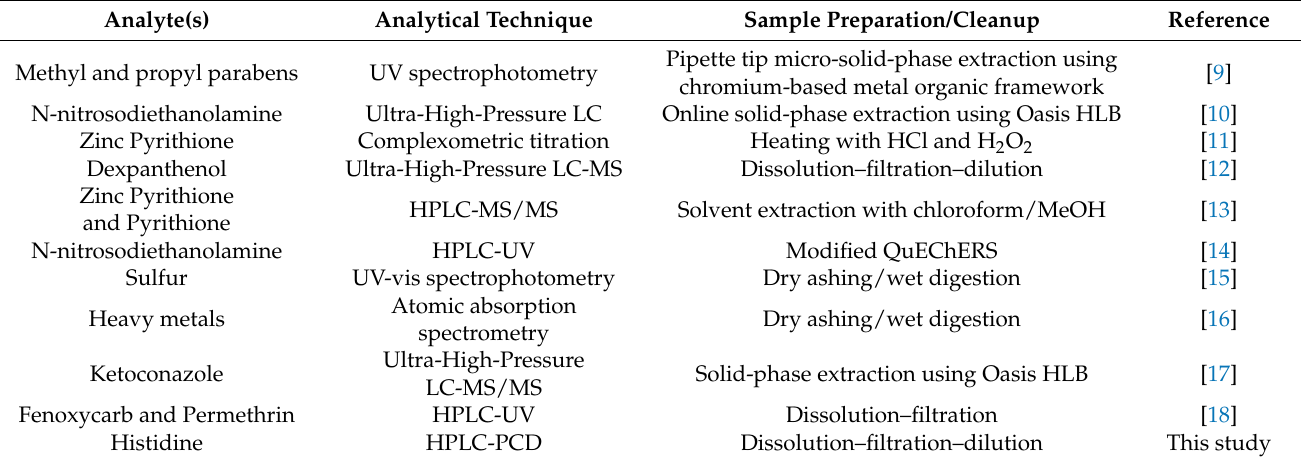
Table 1. Overview of recent analytical methods applied to hair care